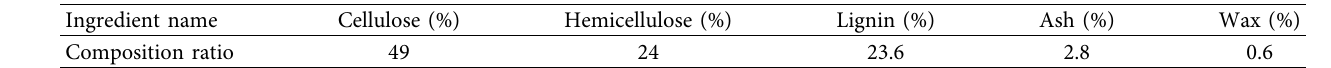
Figure 2: Sugarcane treatment process. Table 2: Contents of chemical components in bagasse.